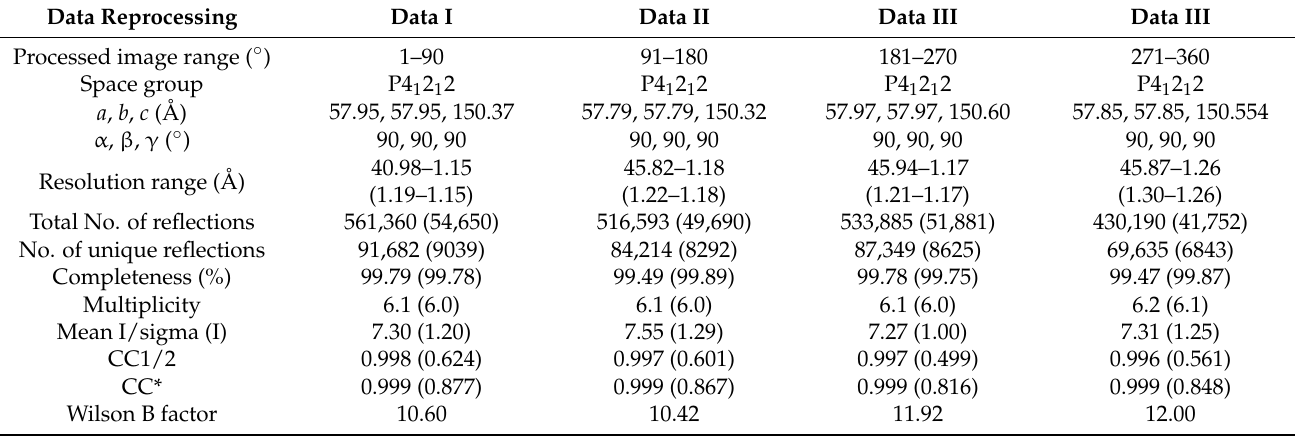
Table 3. Data and refinement statistics of reprocessed Thaumatin 100ms .